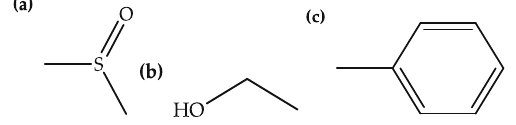
Figure 7: Chemical structures of ( a ) DMSO, ( b ) EtOH, and ( c ) Tol.